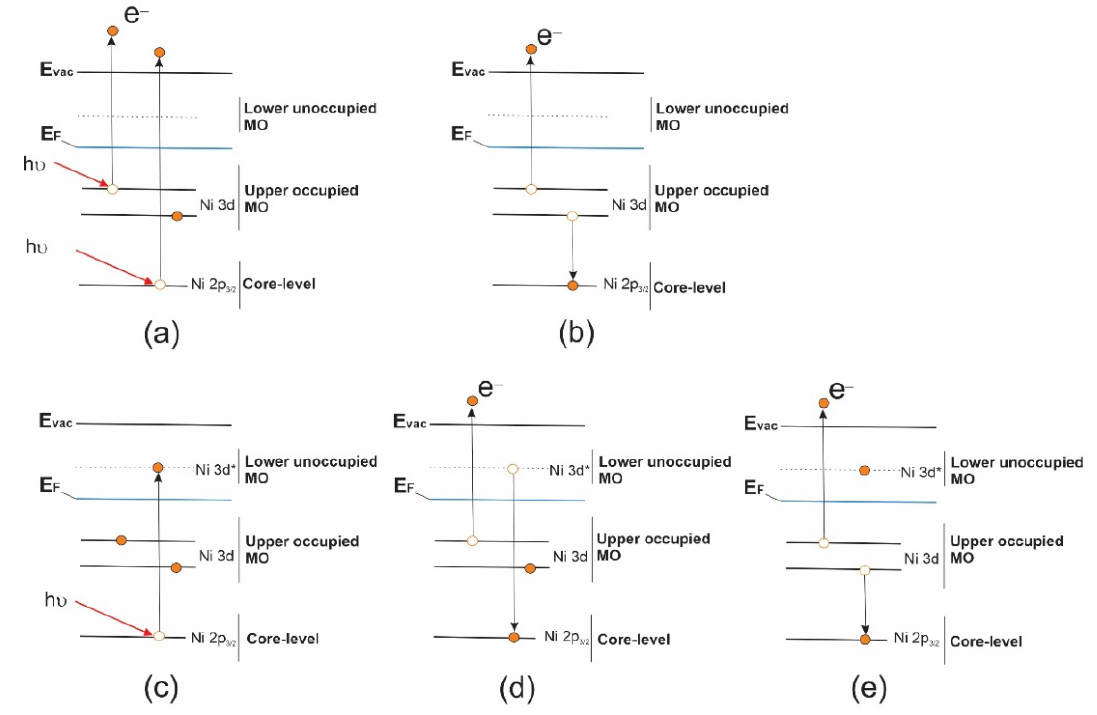
Figure 4. Schematic representation for photoionization absorption process ( a ), normal Auger ( nA ) electron decay process ( b ), resonant core electron excitation process ( c ), Auger electron decay pro- cesses of a resonant excitation: ( d ) participator Auger ( pA ) electron decay and ( e ) spectator Auger ( sA ) electron decay.